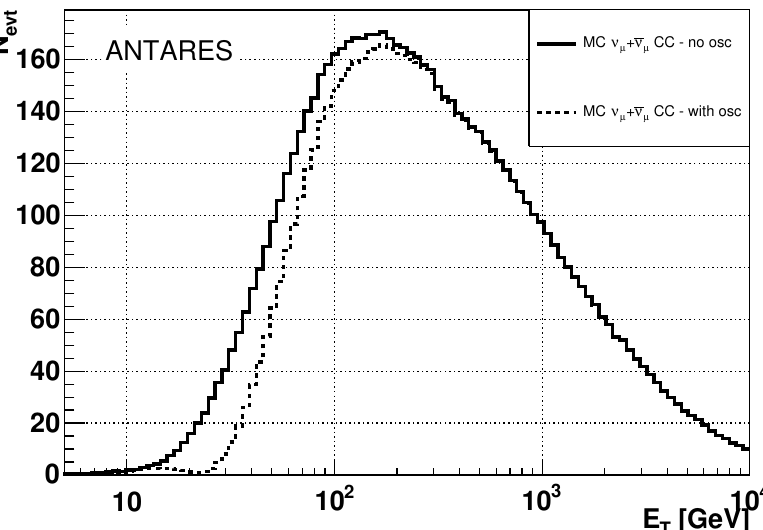
Figure 2 . MC neutrino energy, E T , for selected (cid:23) (cid:22) and (cid:22) (cid:23) (cid:22) CC events: assuming no oscillations (solid line) and a 2-(cid:13)avour oscillation scenario with maximal mixing and (cid:1) m 2 (dashed